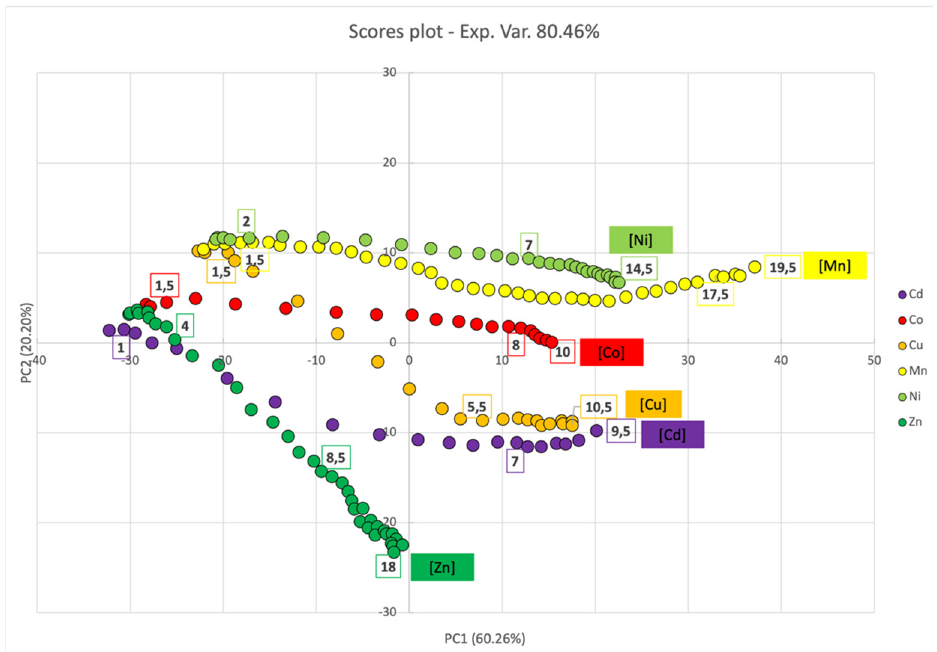
Figure 11. PCA score plot for PC1 and PC2 components upon titration of SPABs of PL 1 -AgNPs@11MUA with each metal ion.